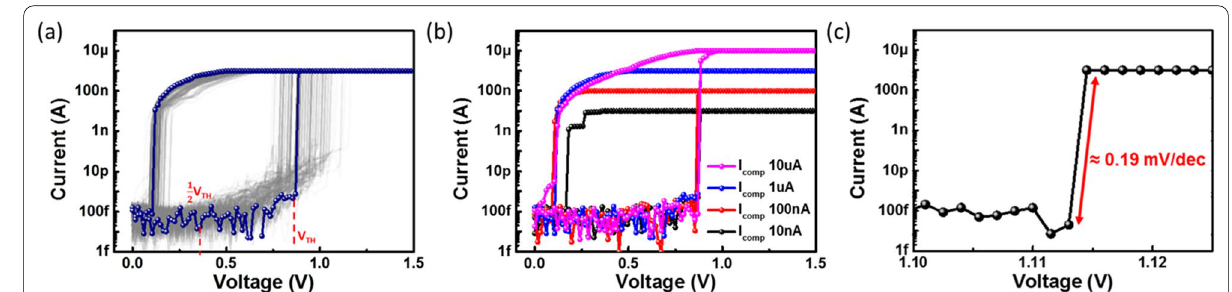
Fig. 3 a I – V characteristics of the Ag-Ga 2 Te 3 selector device for DC voltage sweep results during 100 consecutive cycles. The Ag-Ga 2 Te 3 selector device shows significantly low leakage current (< 100 fA) with an on/off ratio of 10 8 . b TS characteristics of the Ag-Ga 2 Te 3 -based selector device at various I comp values from 10 nA to 10 μA. c Close-up view of the I – V curve at TS that shows a turn-on slope of 0.19